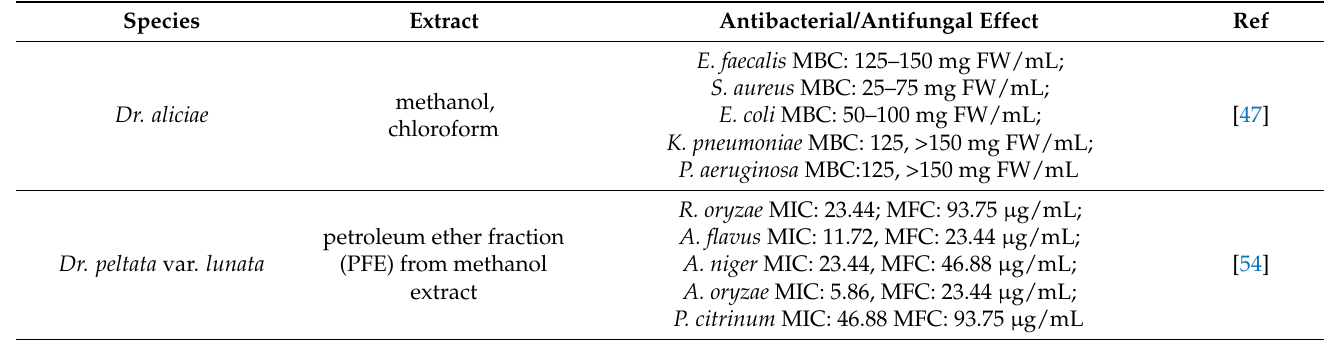
Table 1. Antibacterial and antifungal activity of extracts from Droseraceae, Drosophyllaceae, and Nepenthaceae